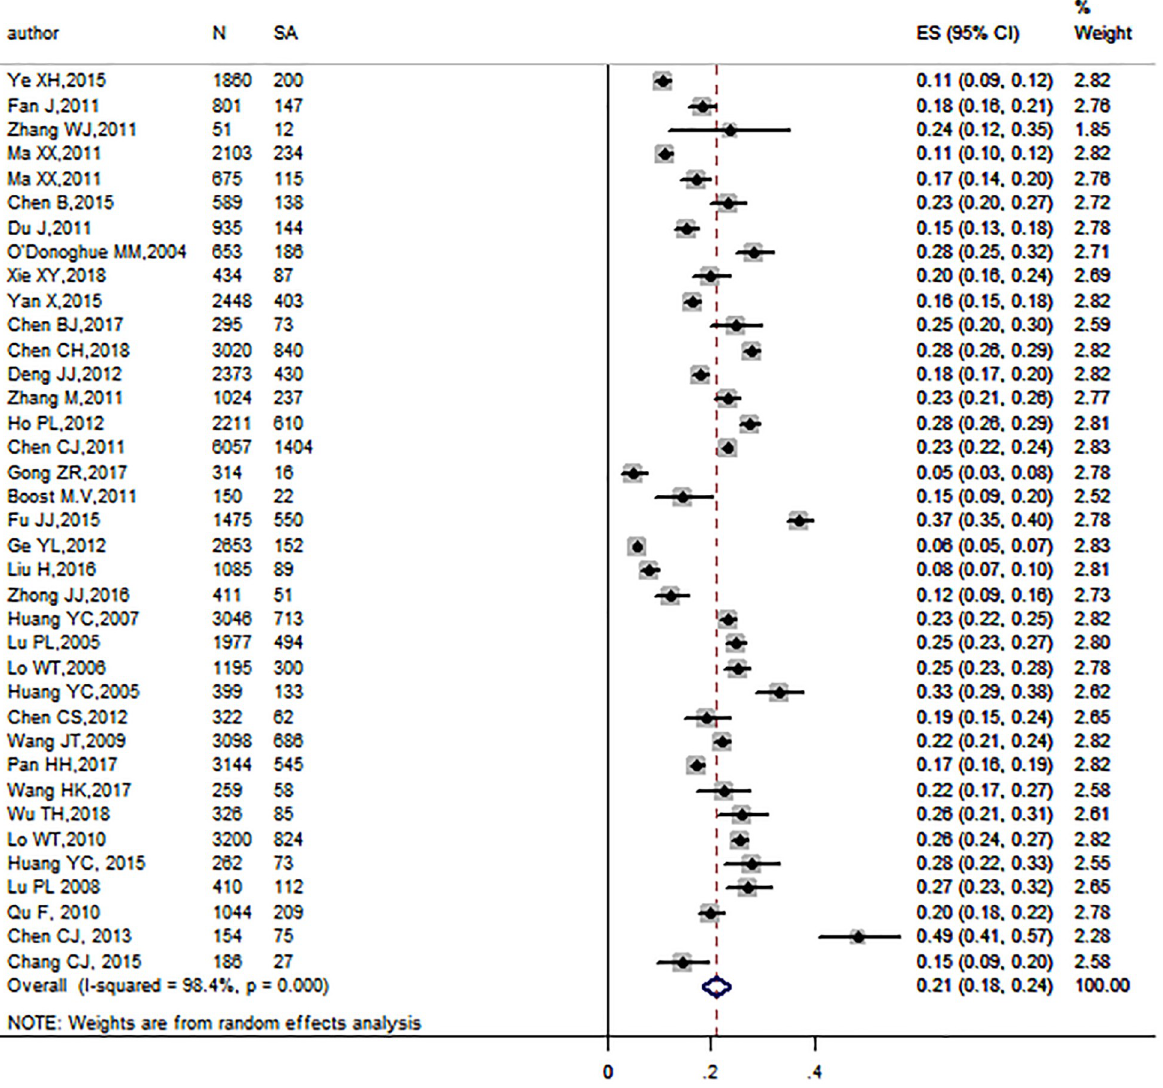
Fig 2. Forest plot for S. aureus prevalence and 95% CI for all selected